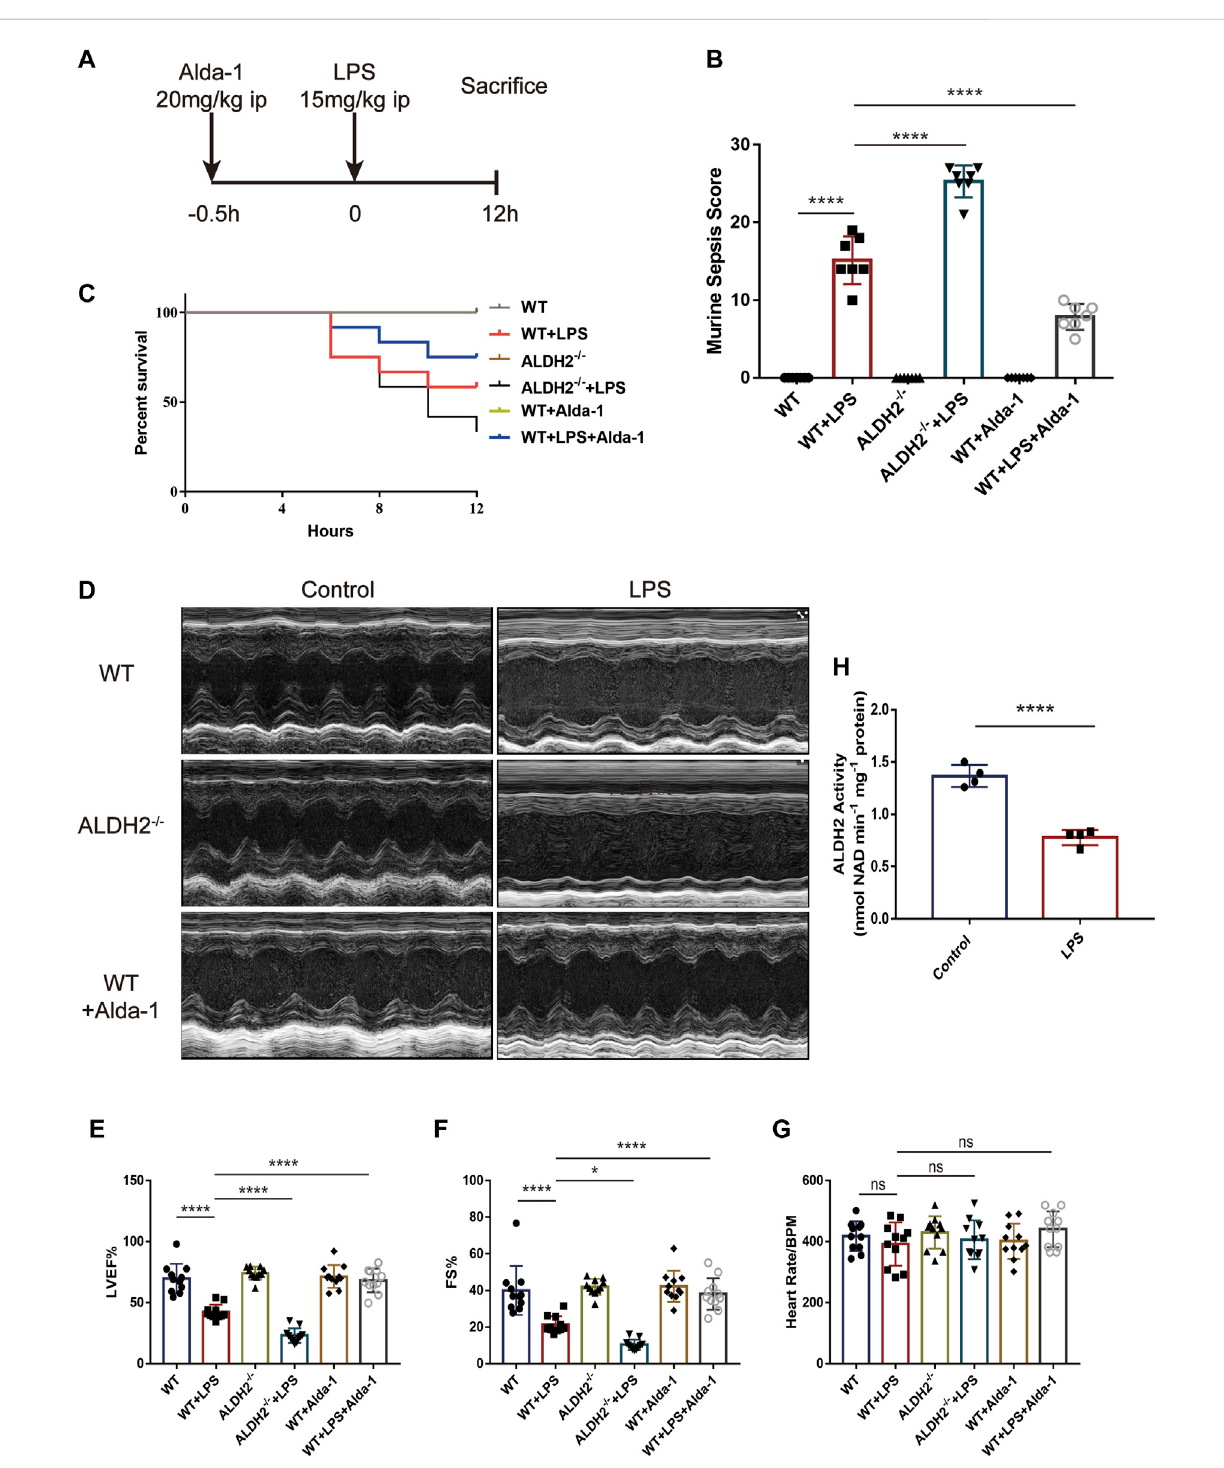
FIGURE 1 Effect of ALDH2 on LPS-induced cardiac dysfunction and mortality. (A) Experimental modeling. Mice were treated with or without LPS (15 mg/kg, i.p. for 12 h). Alda-1 (20 mg/kg, i.p.) was given 30min before LPS injection. (B) Murine Sepsis Score, n = 7 per group. (C) Survival rate was monitored up to 12 h.AKaplan-Meierplotwasusedtoshowthesurvivalrateofmicefromeachgroup, n =12pergroup. (D – G) Representativeechocardiographicimages fromdifferentgroupsand thequantitative analysisofechocardiography, n = 11per group. (H) Thequantitative analysis ofALDH2enzymatic